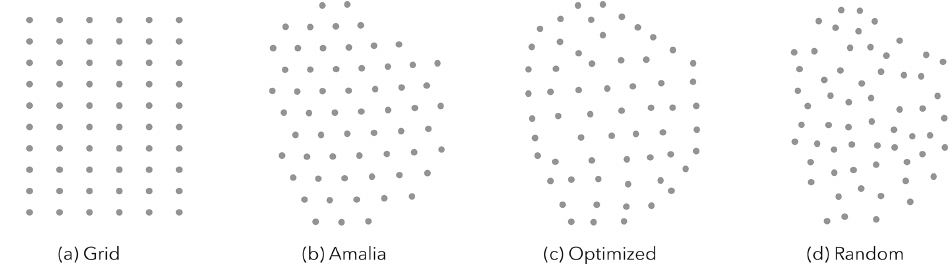
Figure 4. Representative wind farm layouts used in the results. Each dot represents a wind turbine to scale – the dot represents the swept area of the